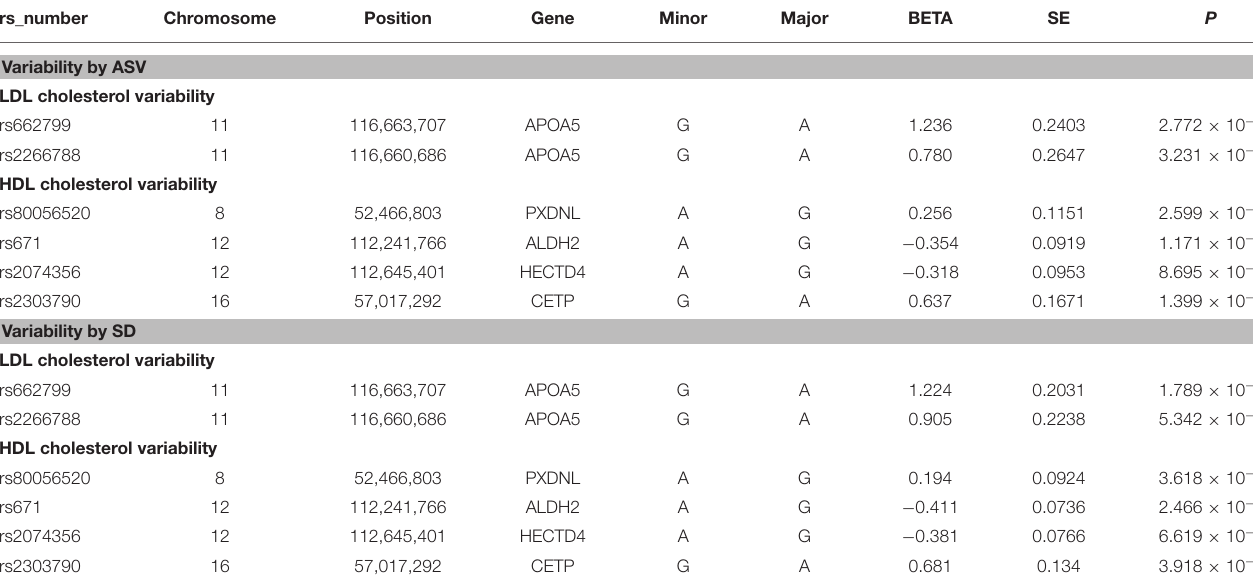
TABLE 2 | SNPs associated with HDL-cholesterol and LDL-cholesterol variabilities. rs_number Chromosome Position Gene Minor Major BETA SE P Variability by ASV